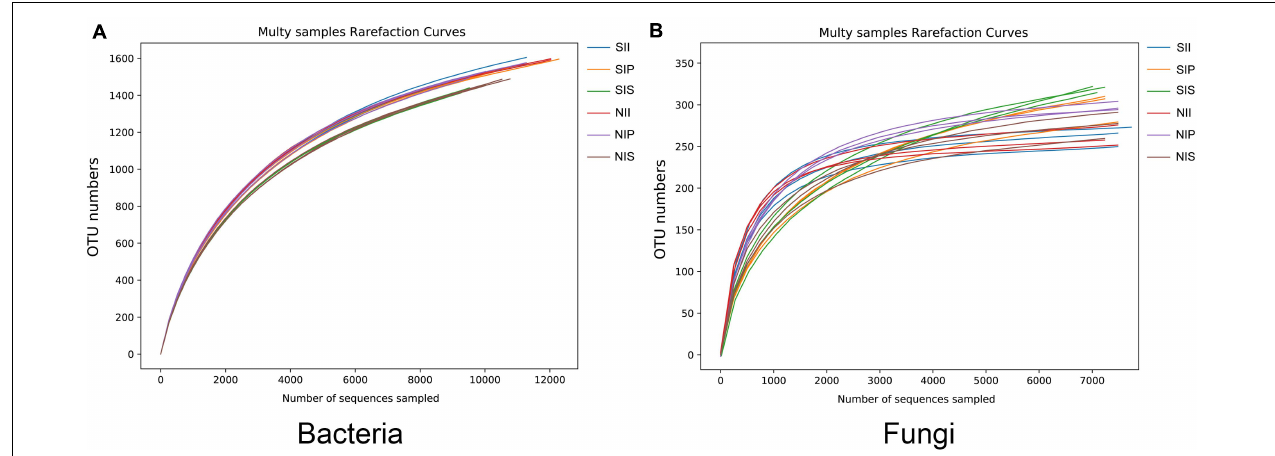
FIGURE 1 | Rarefaction curves of the peanut rhizosphere (IP), sorghum rhizosphere (IS), and interspecific interaction zone (II) microbial communities under different soil conditions (S, 0.25% salt-treated soil condition; N, normal soil condition). (A) Rarefaction curves of bacterial community. (B) Rarefaction curves of fungal